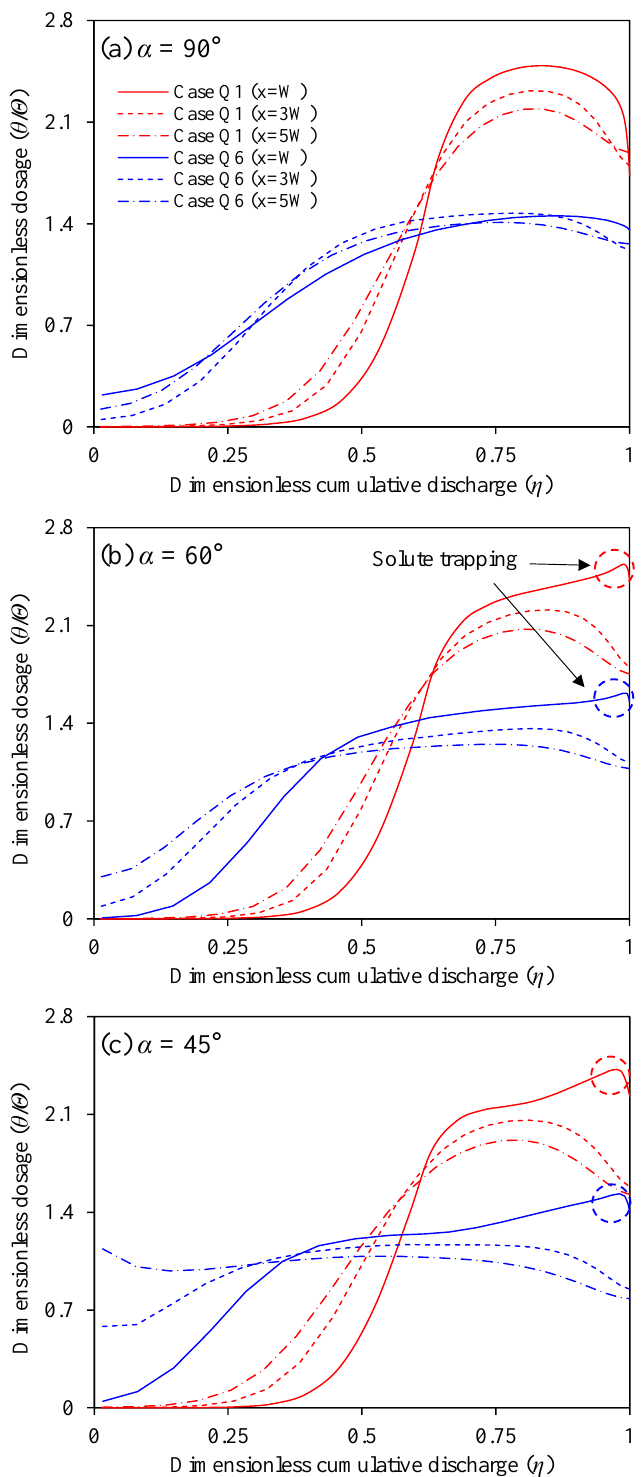
Figure 10. Dimensionless dosage curve variations with the discharge ratio change ( η was calculated from the left bank ( y / W = 0) to the right bank ( y / W = 1), which means η = 0 at y/W = 1 and η = 1 at y/W = 0).